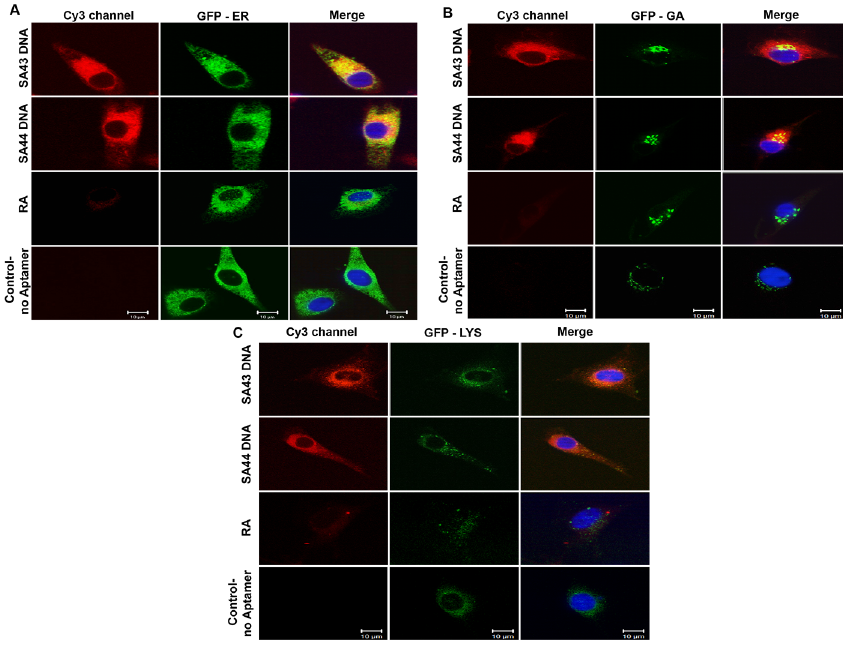
Fig 4. Subcellular localisation of SA43 and SA44 with endoplasmic reticulum (ER), golgi apparatus (GA) and lysosomes. Live U87MG cells were incubated separately with Cy3 labelled SA43, SA44 and RA at a concentration of 100 nM for 24 hours. CellLight ER and GA labelled with GFP, and lysotracker green DND- 26 were then incubated to the cells to track the co-localisation of aptamers with ER, GA and lysosomes respectively, and fixed using 4% PFA. The nuclei were counterstained with DAPI (blue). Cells with random aptamer and marker alone were used as control. Bar = 10 μ m.